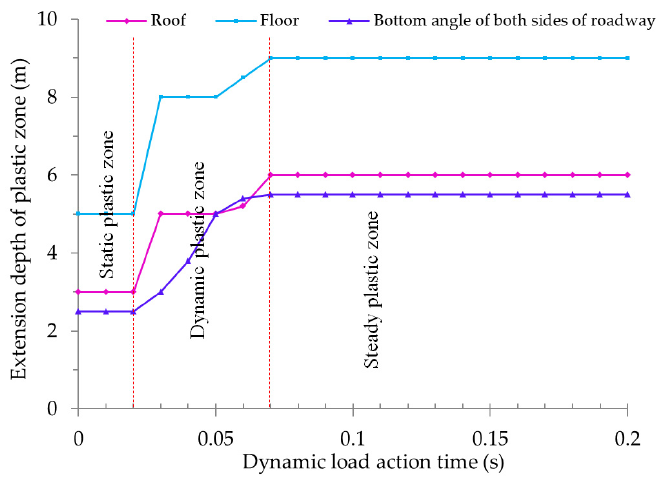
Figure 8. Variation Tendency Chart of the Expansion Depth of Plastic Zone in the Surrounding Rock of Roadway. of